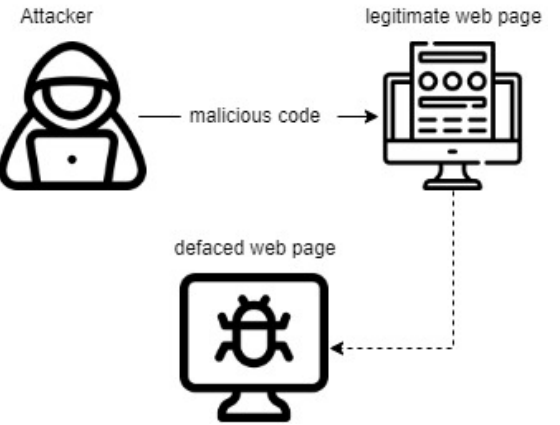
Figure 1. Overview of website defacement.